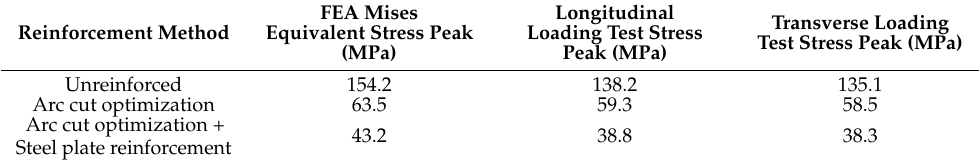
Table 2. Stress comparison before and after arc notch optimization reinforcement (MPa).